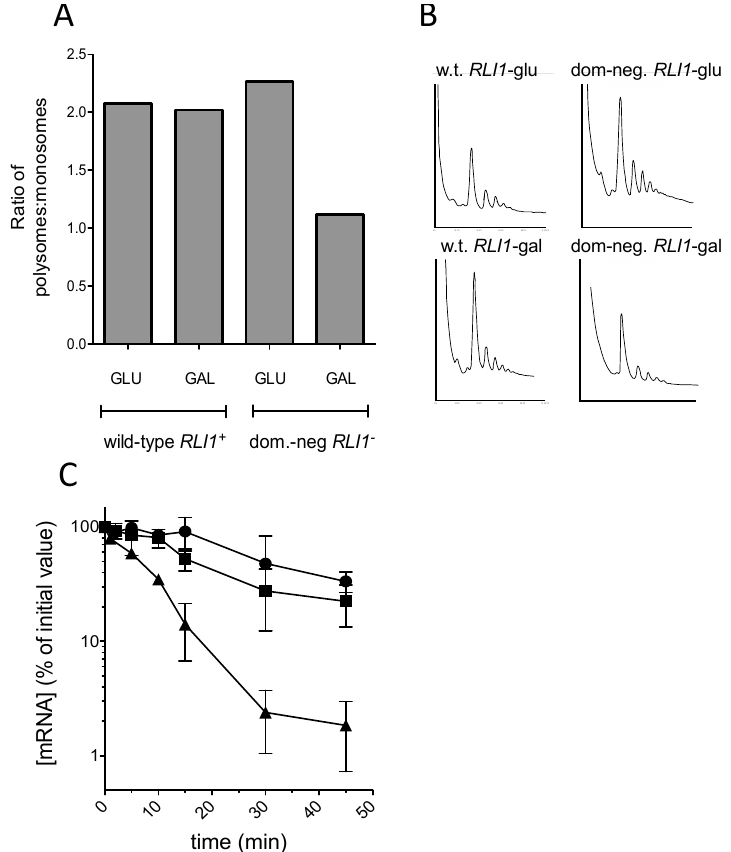
Figure 5. Failure to recycle ribosomes via Rli1 does not destabilize mRNAs. ( A , B ) The translation defect conferred by a dominant negative RLI1 allele was confirmed by carrying out polysome profile analysis on the dominant-negative RILI1 allele, and RLI1 + wild-type control, both under control of the GAL promoter. Polysomes were analyzed in the presence of glucose (Rli1p-repressed) and galactose (Rli1p-induced), confirming a reduction in the polysome:monosome ratio, indicative of a ribosome recycling defect, during galactose-induction of the dominant-negative Rli1p. ( C ) The mRNA stability of a PGK1 reporter mRNA carrying a premature stop codon at position 225 was measured in a nonsense-mediated decay defective genetic background either in the presence (squares) or absence(circles) of a dominant negative RLI1 allele. For reference, the mRNA decay profile of the codon 22 PGK1 allele is presented (triangles). Measurements were made in independent biological replicates ( n = 3, ± standard